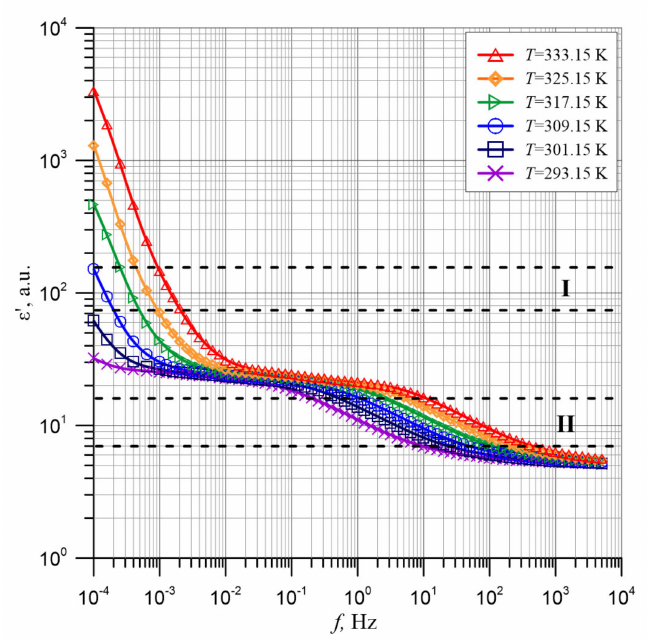
Figure 3. Frequency dependence of permittivity of the composite of cellulose, transformer oil and water nanoparticles for its content of (5.0 ± 0.2)% by weight measured at temperatures from 293.15 to 333.15 K. Continuous lines—polynomial